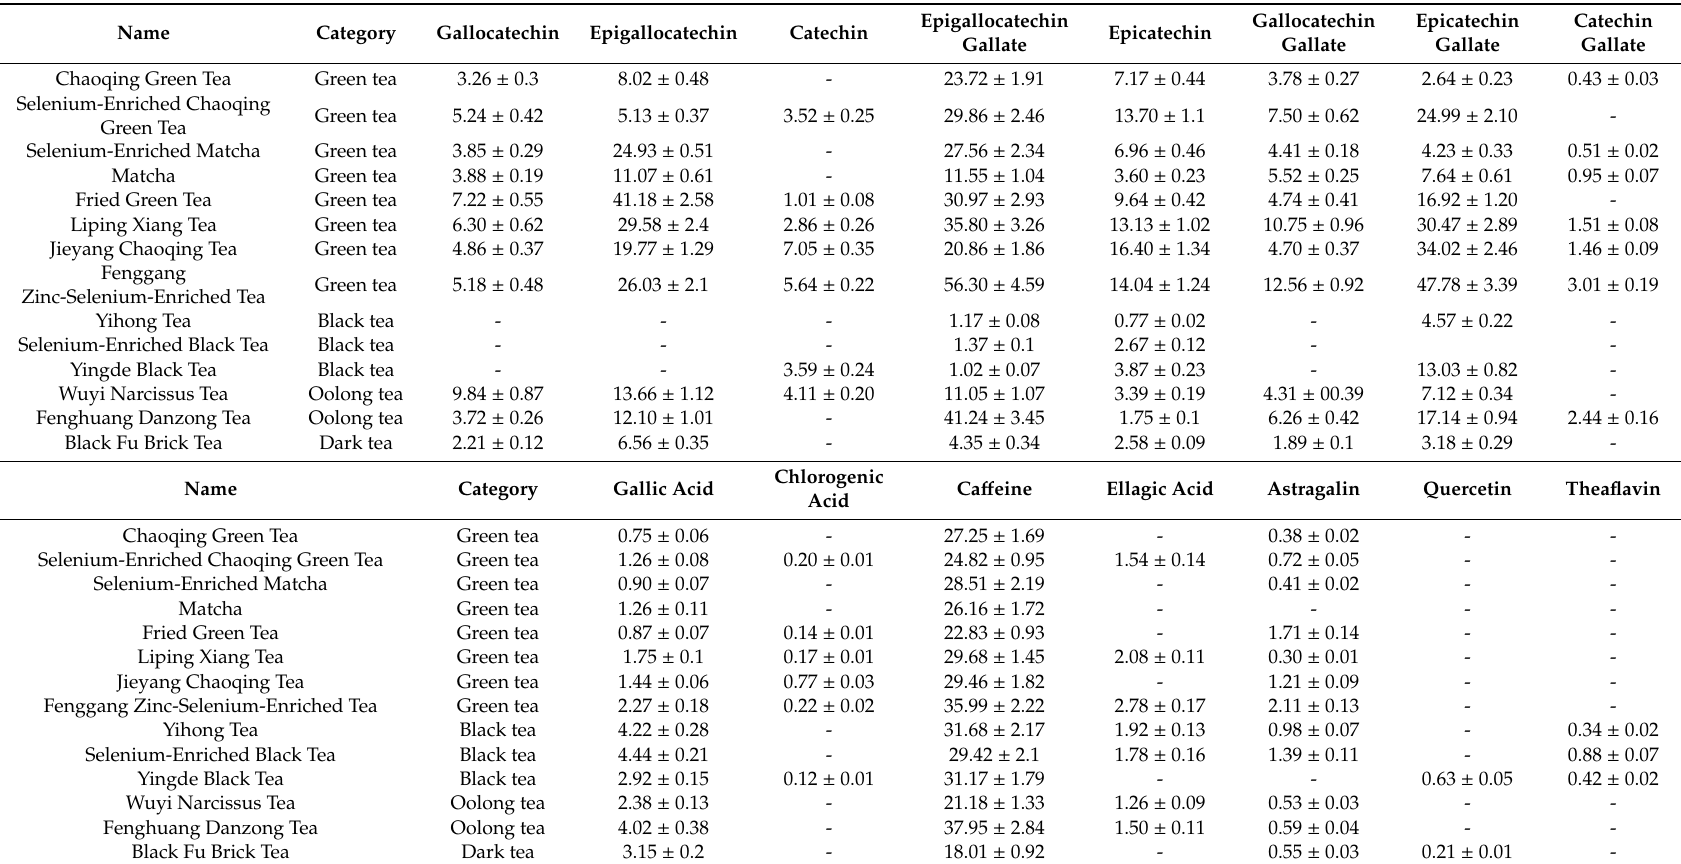
Table 3. The contents (mg / g DW) of main phytochemicals in selected